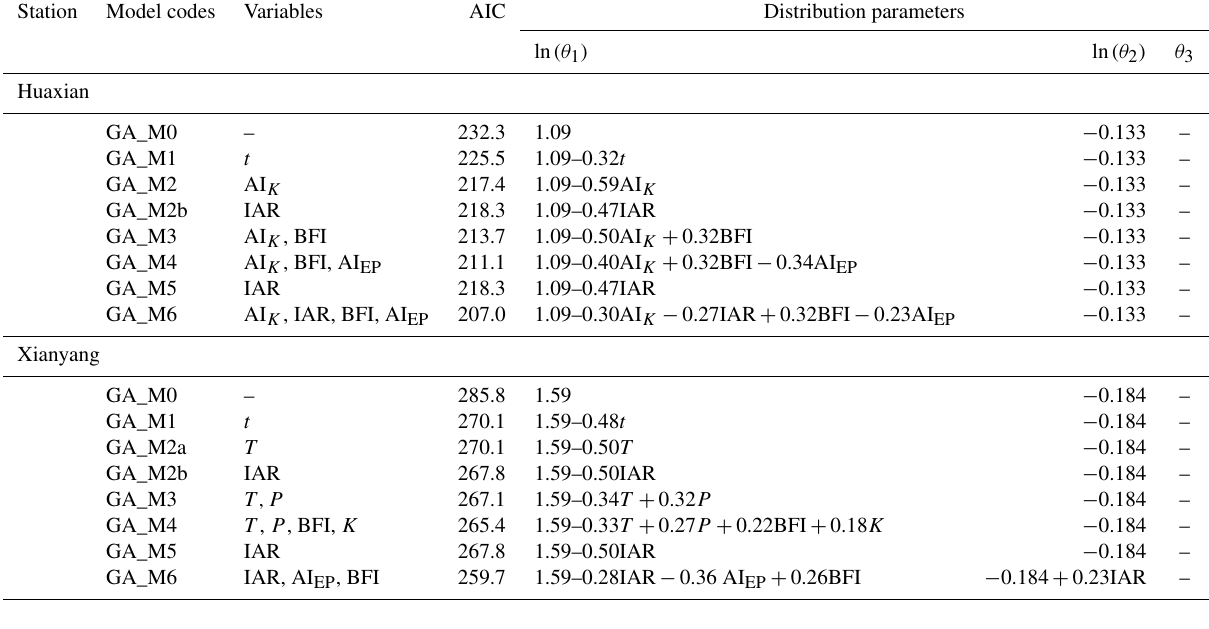
Table 5. The summary of frequency analysis using GA distribution for AM 30 in Huaxian and Xianyang.